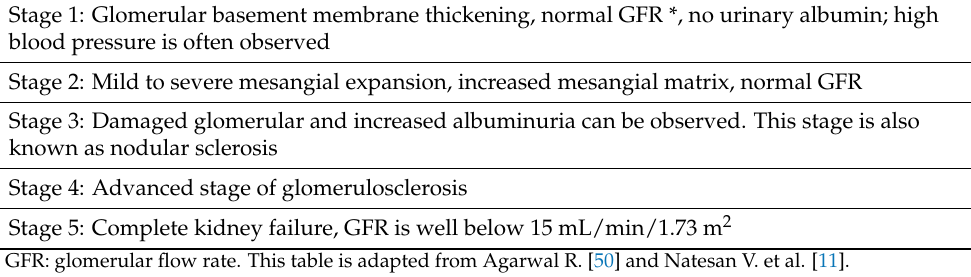
Table 1. Pathophysiological stages of diabetic nephropathy.